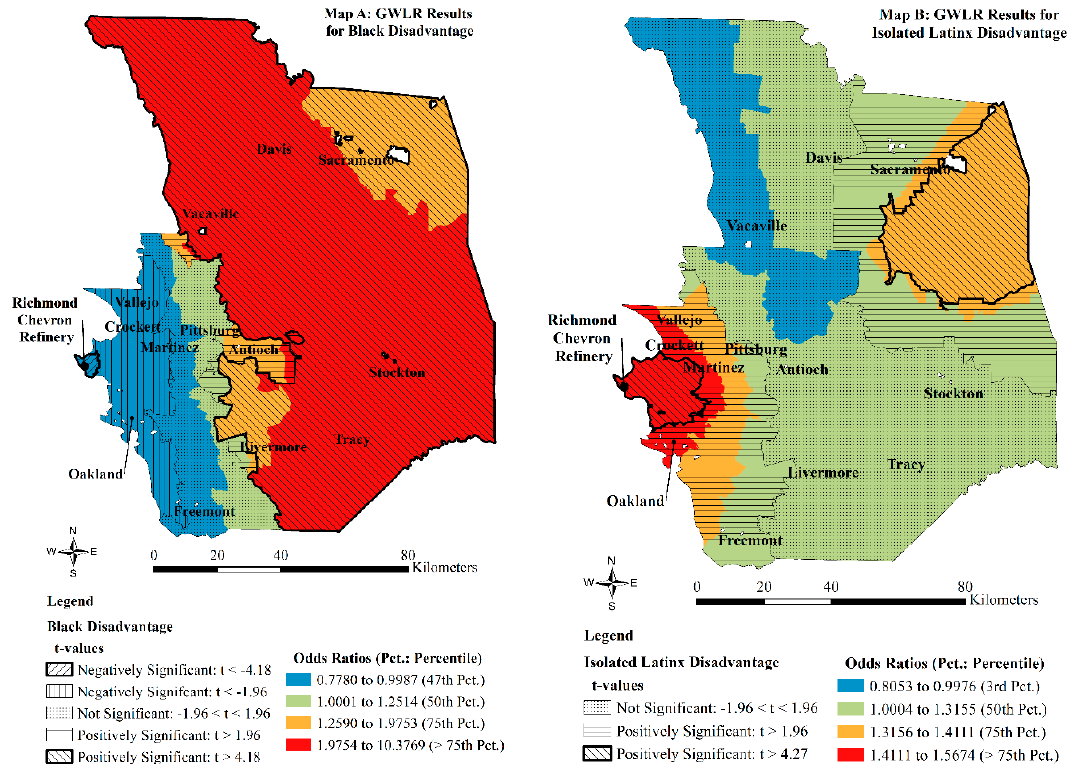
Figure 11. GWLR t -values and odds ratios for Map ( A ) Black disadvantage and Map ( B ) isolated Latinx disadvantage.